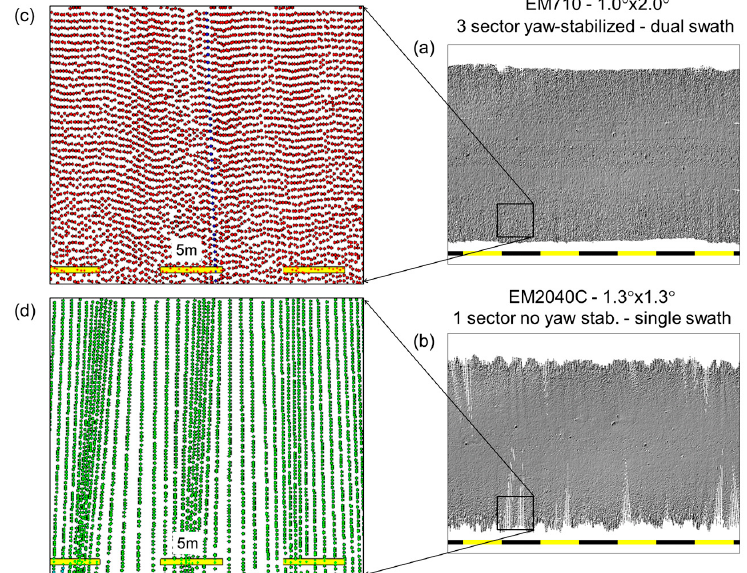
Figure 9. Impact of multisector yaw and pitch stabilization and dual swath. Two simultaneously acquired swaths of multibeam data (systems mounted on the same vessel): ( a ) Yaw stabilized coverage (and dual swath); ( b ) coverage without yaw stabilization; ( c ) sounding density showing even coverage; ( d ) sounding density showing irregular coverage.